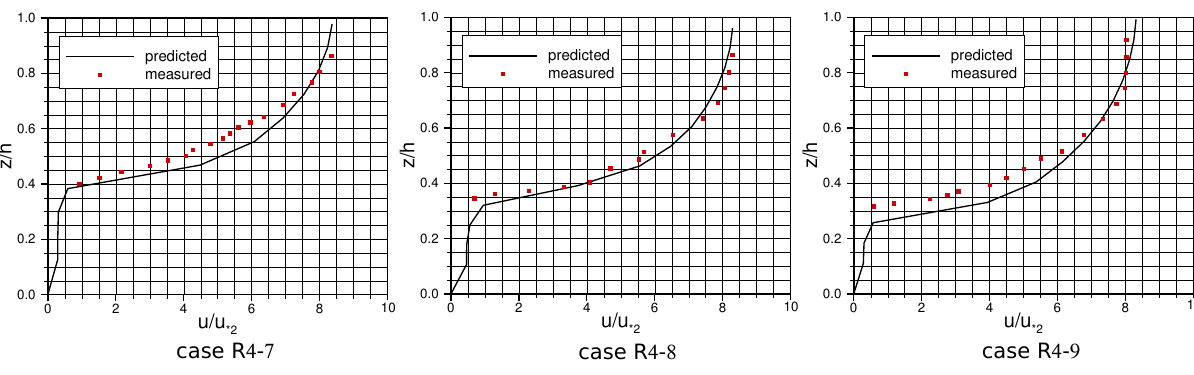
Figure 10. Comparison of the experimental measurements [48] and the predicted